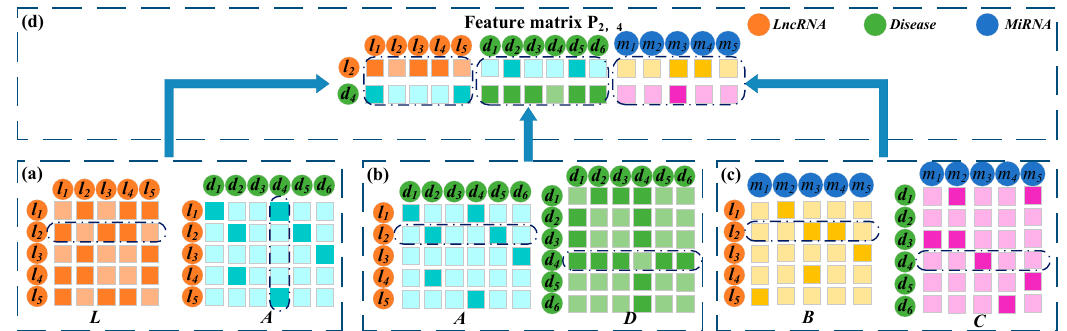
Figure 3. Construction of the embedding matrix of 𝑙 (cid:2870) - 𝑑 (cid:2872) pair. ( a ) Construction of the first part of the embedding matrix based on the similarity between 𝑙 (cid:2870) and the other lncRNAs and the association between 𝑑 (cid:2872) and all lncRNAs. ( b ) The second part of the embedding matrix was constructed based on the similarity between 𝑙 (cid:2870) and the other lncRNA and the association between 𝑑 (cid:2872) and the other diseases. ( c ) Construction of the third part using the lncRNA-miRNA interactions and miRNA-disease associations. ( d ) Construction of the final embedding matrix 𝑷 𝟐,𝟒 by combining the representations of the first, second, and third